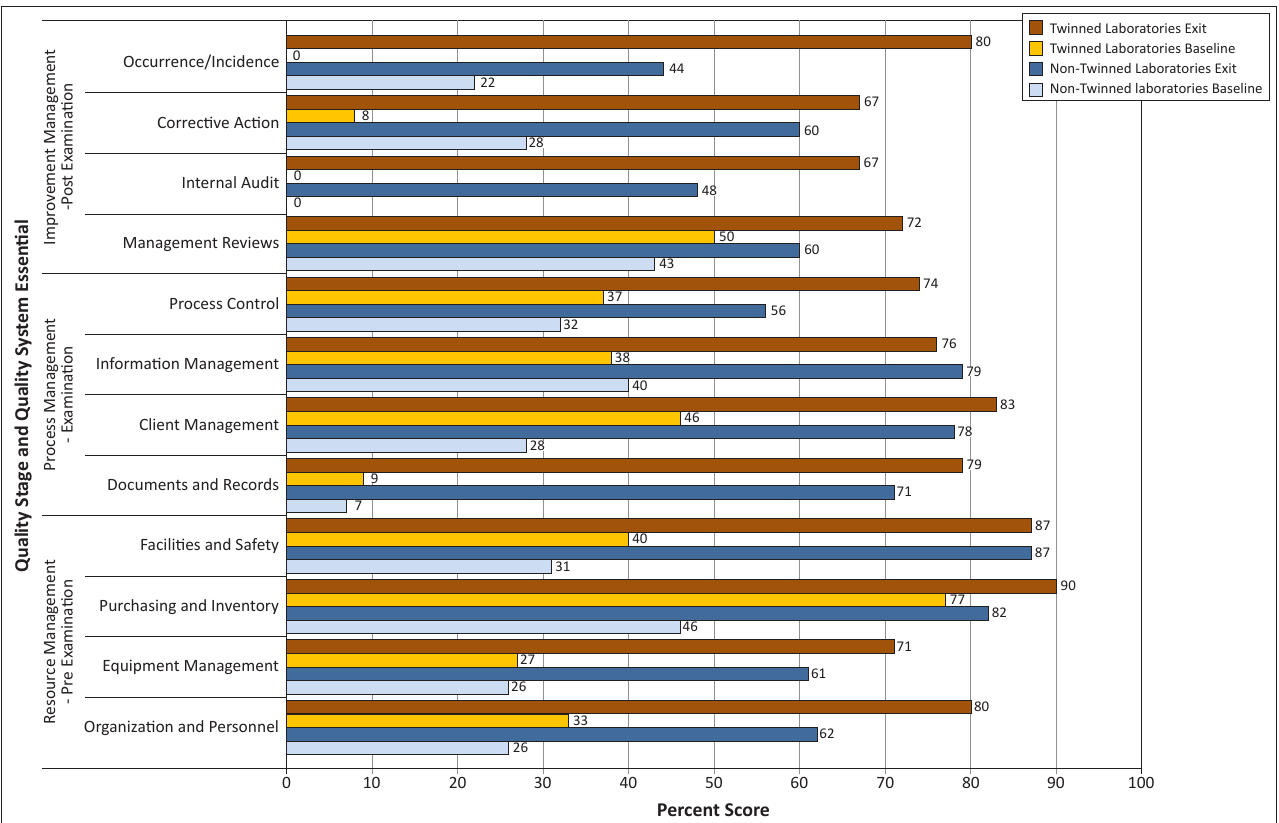
FIGURE 2: Performance on 12 Quality System Essentials for twinned and non-twinned laboratories at baseline and exit of the Strengthening Laboratory Management Toward Accreditation (SLMTA)